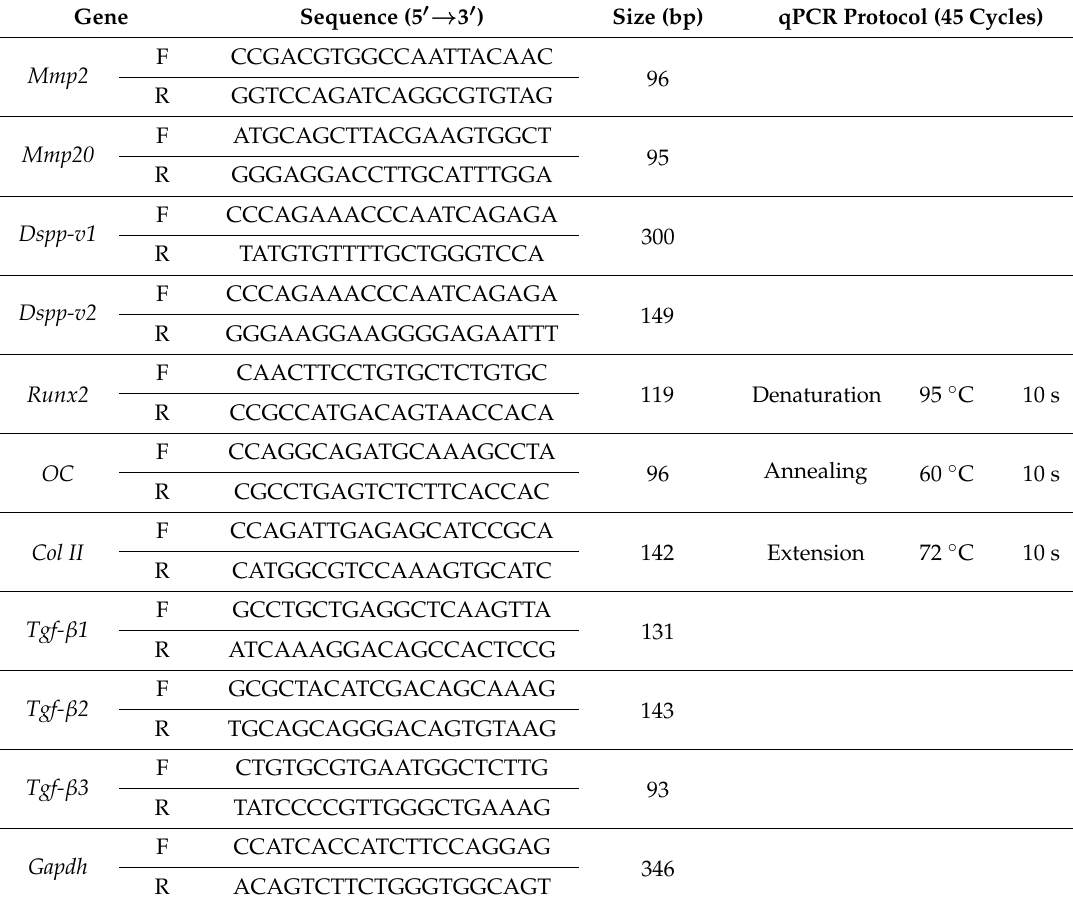
Table A1. Selected primers, size of amplified product for qPCR analysis shown in main Figure 3. Gene Sequence (5 (cid:48) → 3 (cid:48) ) Size (bp) qPCR Protocol (45